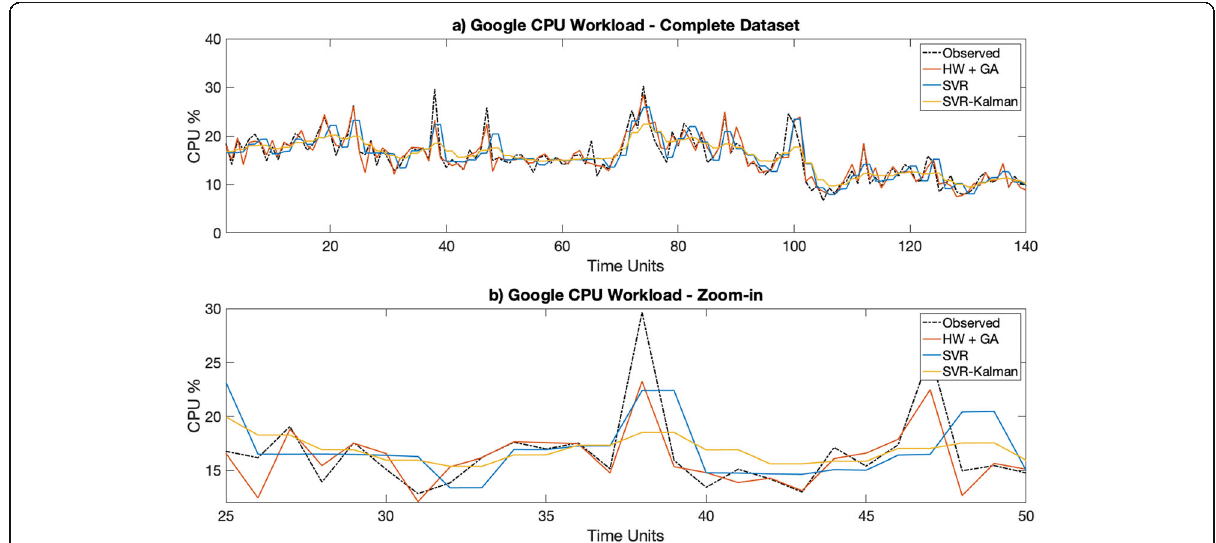
Fig. 5 Google Observed and Estimated data: a Complete dataset, b